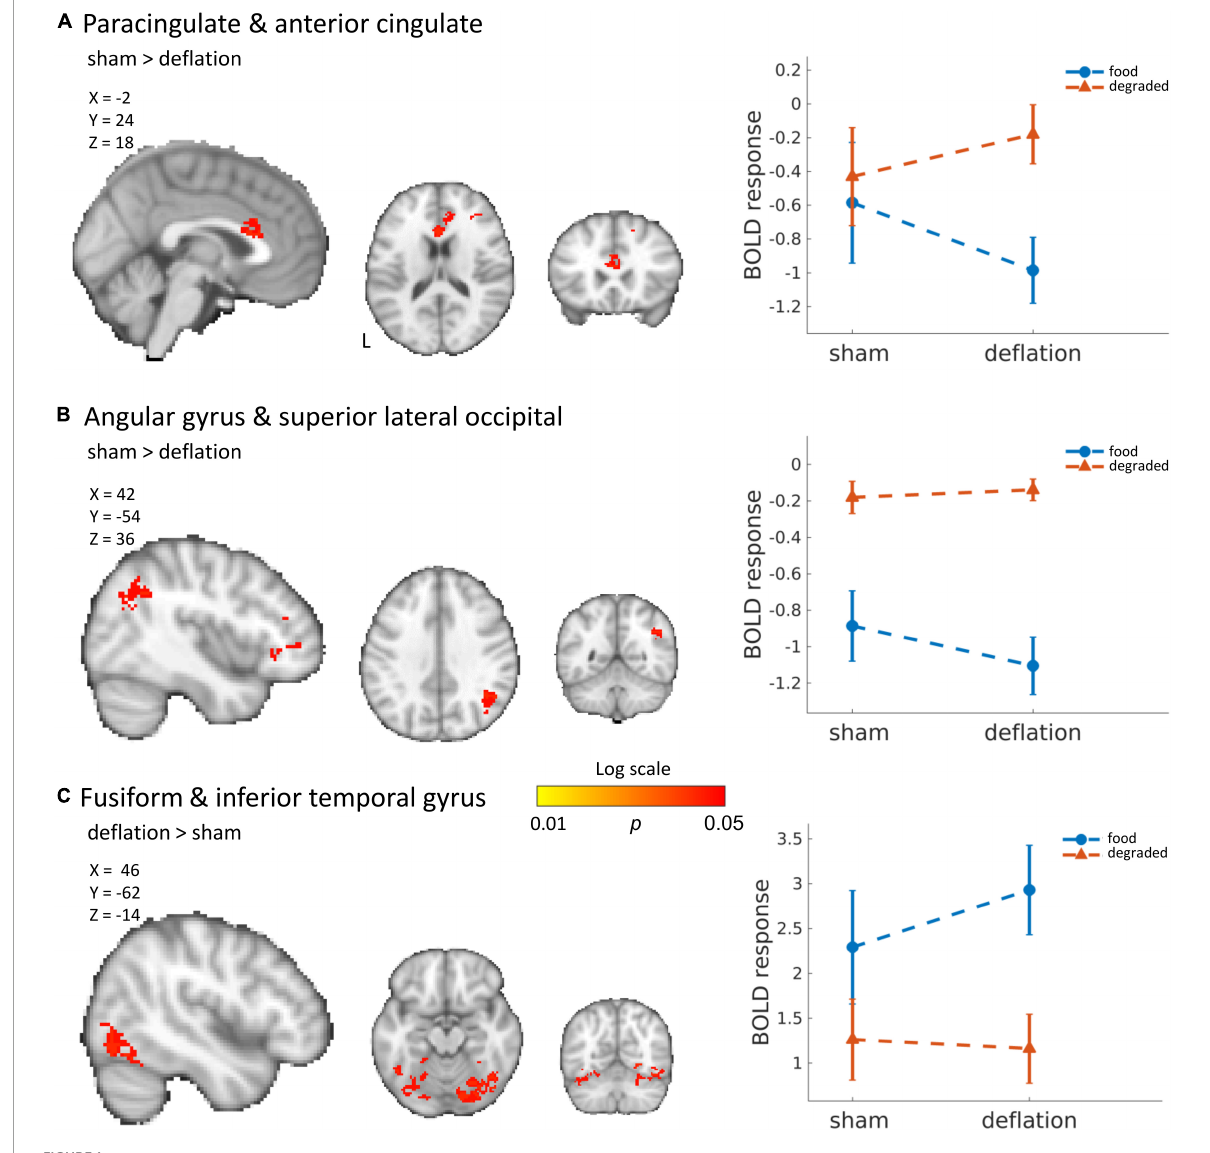
FIGURE1 Significant deactivation in the deflation compared to sham condition for food images compared to degraded images in the cingulate cortex (A) and angular and superior lateral occipital cortex (B). Significantly increased activation to food images (compared to degraded images) in the deflation condition in the fusiform gyrus and inferior temporal gyrus (C). Line plots show mean activation in the respective significant clusters. Error bars represent SEM. Brains are in neurological orientation. See also Table 2 . Unthresholded statistical maps have been uploaded to NeuroVault.org (Gorgolewski et al., 2015) and are available at